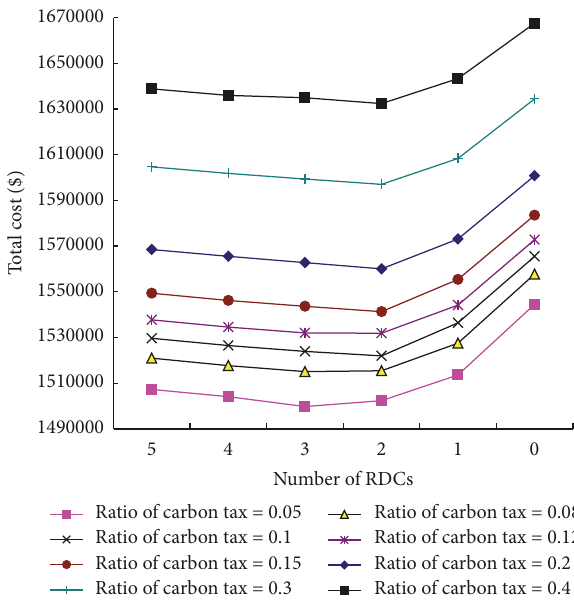
Figure 6: Effects of increasing the ratio of carbon tax.